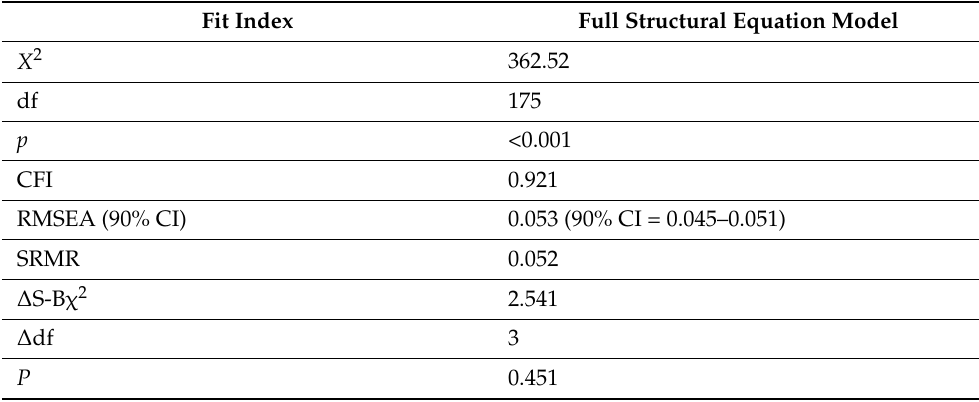
Table 5. Model Fit Indices for the full structural equation